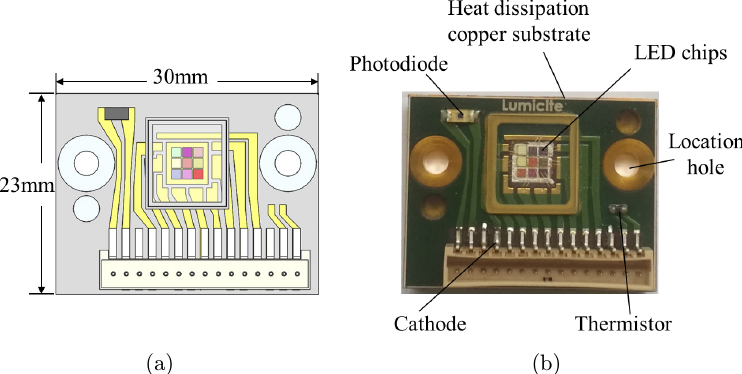
Fig. 2. (a) Schematic and (b) photograph of the self-developed multi-wavelength LED array excitation source.